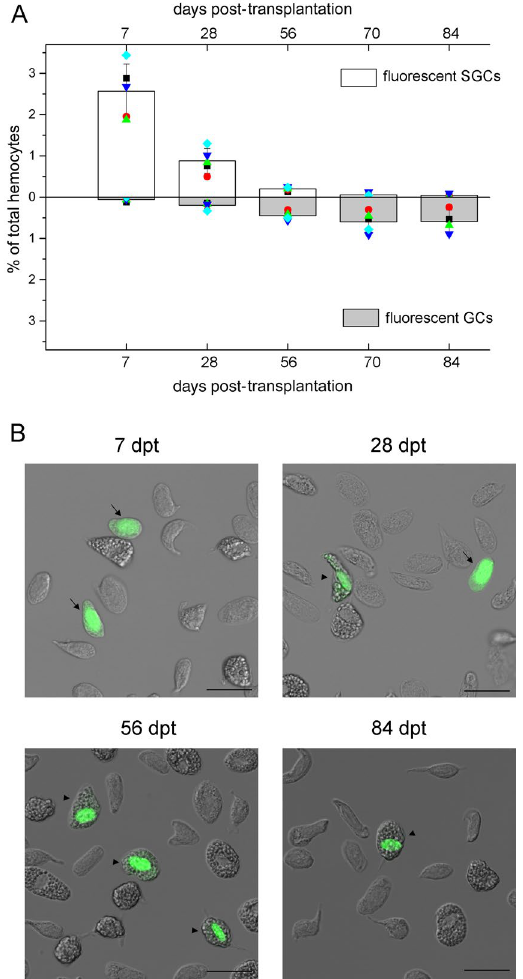
Figure 5. Almost all transplanted SGCs develop into GCs. The purified SGCs were labeled with a nontoxic fluorescence cell tracer (green) and transplanted into the recipients. Hemocytes were taken from the recipients and analyzed at different time points. The percentages of fluorescent GCs and SGCs in the total hemocytes were determined by flow cytometry and fluorescence microscopy, and over 10,000 cells were analyzed for each sample ( A ). Five animals were used in each group. Data from different individuals are indicated by different symbols. Images of transplanted cells are shown ( B ). Fluorescent SGCs are indicated with arrows, and fluorescent GCs are indicated with arrowheads. Bar, 25